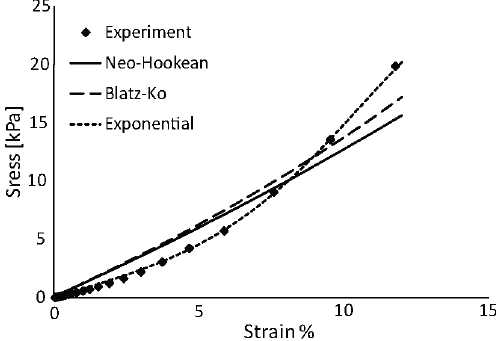
Figure 3. Fitting to experimental data. Representative fitting of the neo-Hookean, Blatz-Ko and exponential constitutive equations to the experimentally measured stress-strain response of a tumor specimen.